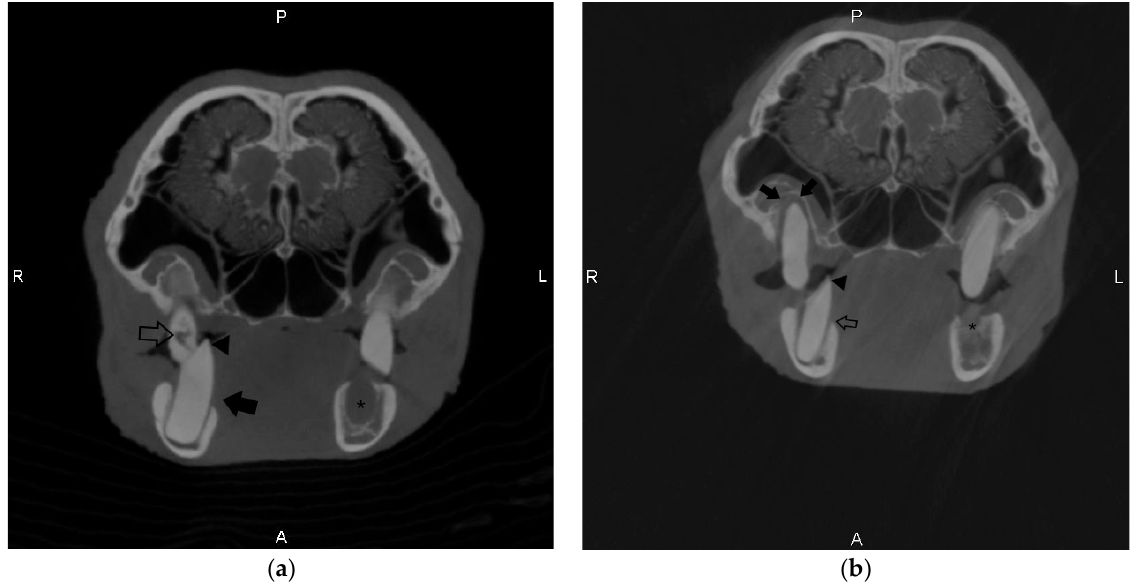
Figure 2. Transverse images of the skull of Case 1 using cone-beam computed tomography (CBCT) taken at two time points. Images were captured at the level of the third molar tooth. ( a ) Taken in 2019 and shows horizontal bone loss affecting the right third mandibular molar (black arrow), a large point of the right third mandibular molar (arrowhead), caries-like lesions associated with the crown of the right third maxillary molar tooth (open arrow), and a missing left third mandibular molar tooth with an associated alveolar defect (Asterix). ( b ) Taken in 2021 and shows significant alveolar bone loss surrounding the tooth root of the right third maxillary molar (solid arrows) and continued horizontal bone loss associated with the right third mandibular molar tooth (open arrow). The right third mandibular molar is axially displaced relative to the maxillary molar, and there is a significant point associated with the right third mandibular molar. The left third mandibular molar tooth is absent, and there is an alveolar defect at the level of the missing tooth (Asterix).